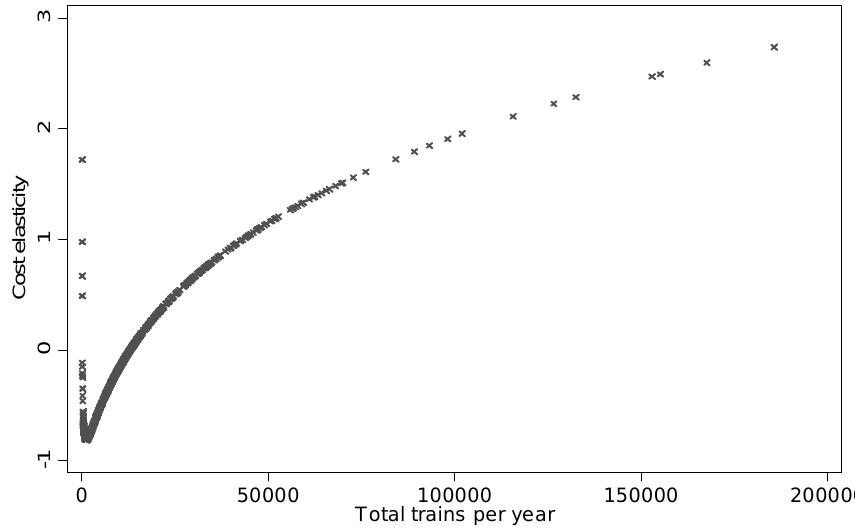
Figure 4. Infrastructure operation cost elasticity with respect to output – Model IV The negative point estimate of the output elasticity looks doubtful at first sight (-0.036 (standard error 0.19)), but if we look at individual estimates, they range from negative to positive (Figure 4). In fact, low volume tracks have negative elasticities, but at 13,000 trains per year (or 35 trains per day) the sign shifts from negative to positive. This means that additional trains contribute positively (reduce costs) to winter maintenance up to a certain level, but this positive effect is exhausted as volumes exceed this threshold. This finding is in line with a commonly held view